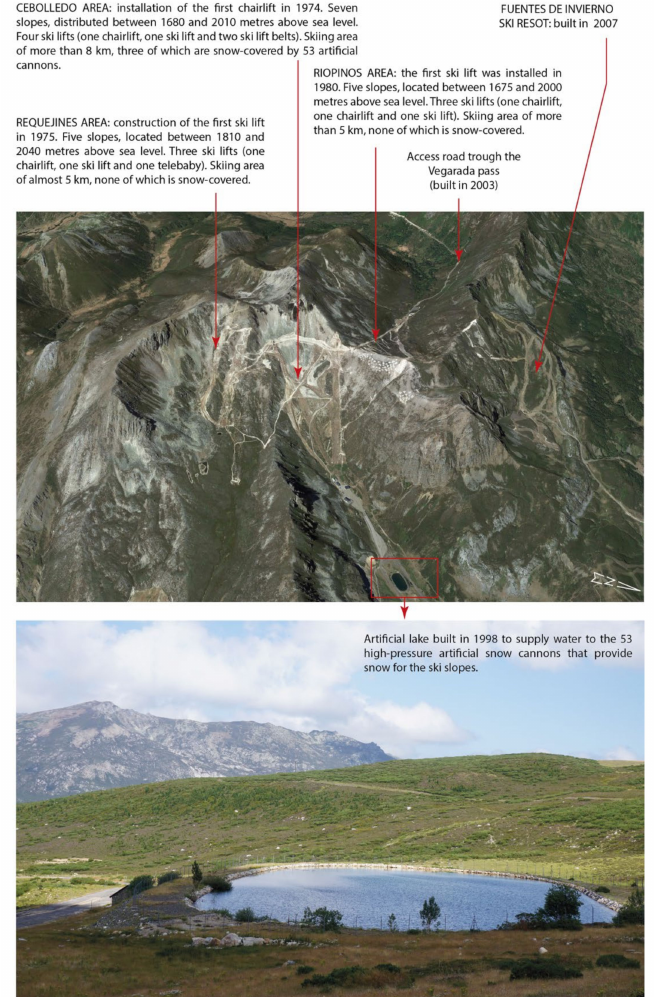
Figure 15. General view of the Cebolledo valley (Google Earth image from 2016), showing the skiable areas, in which the intense and irreversible landscape degradation caused in this high mountain area by the construction of the ski resort can be recognised. Photograph by the authors. Focus with camera on Figure through Onirix site or use the link [x].